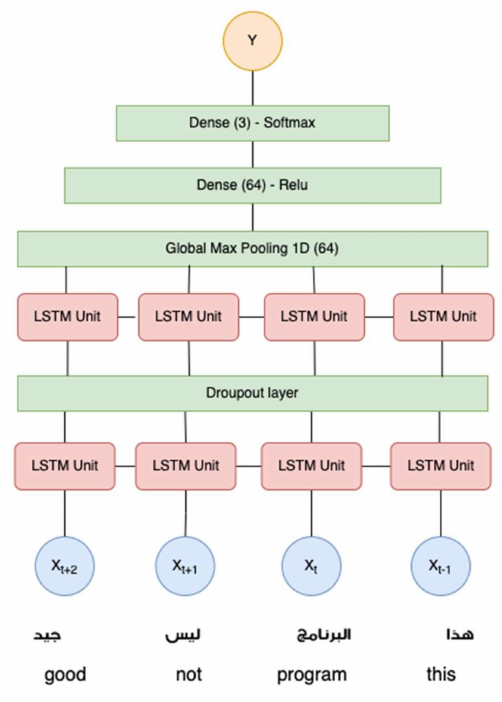
Figure 6. LSTM double-layer